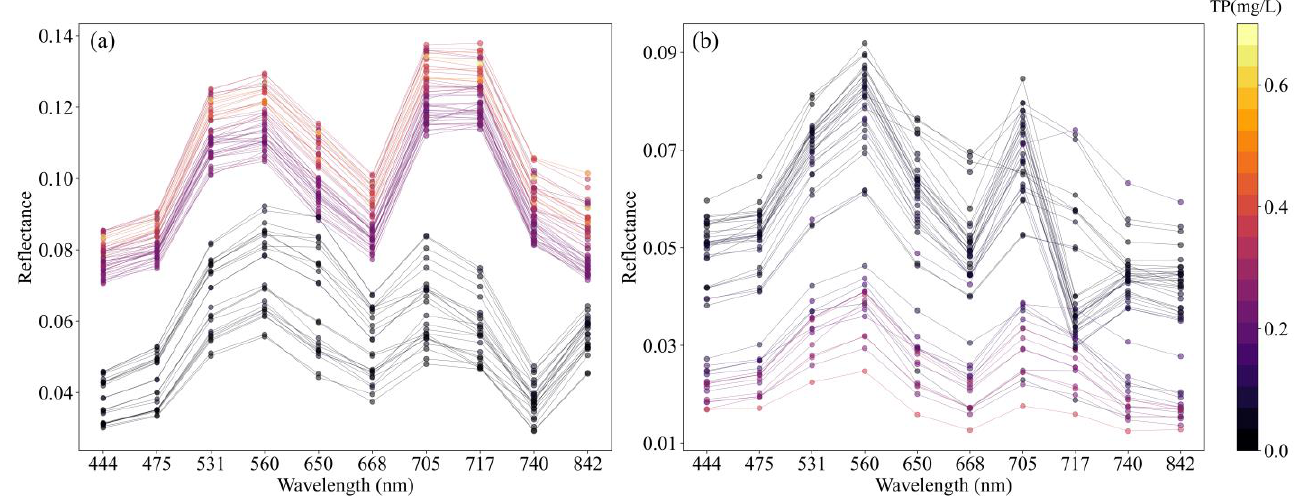
Figure 3. Reflectance curves of sampling points: ( a ) research areas A and B, ( b ) research area C.